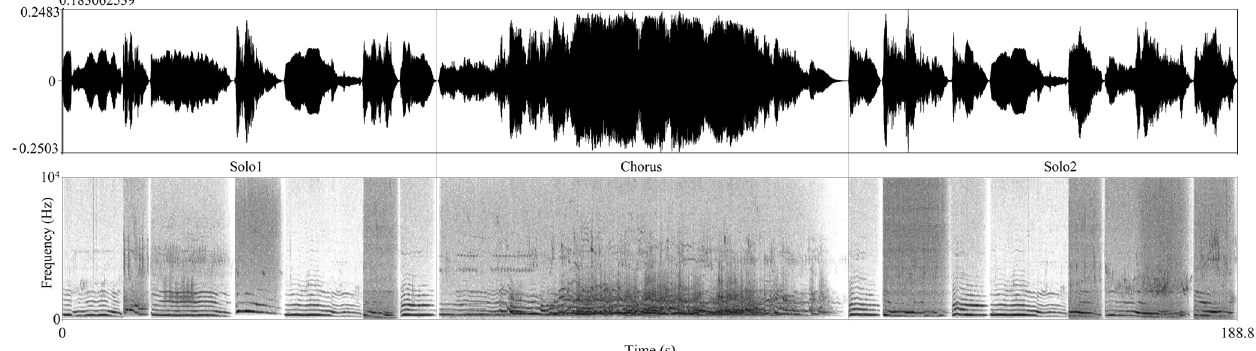
Fig. 4 Construction of the howling stimulus. It consisted of three parts in a de fi ned order: Solo1, Chorus and